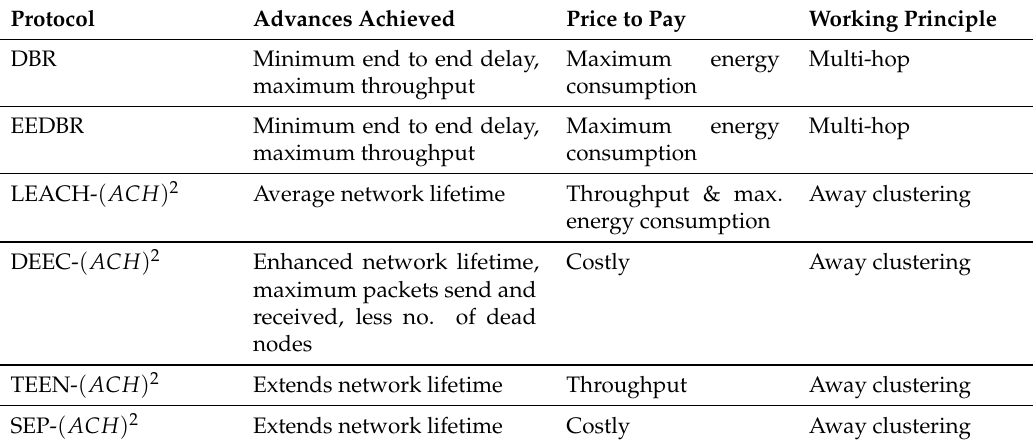
Table 6. Comparison of Proposed and Existing